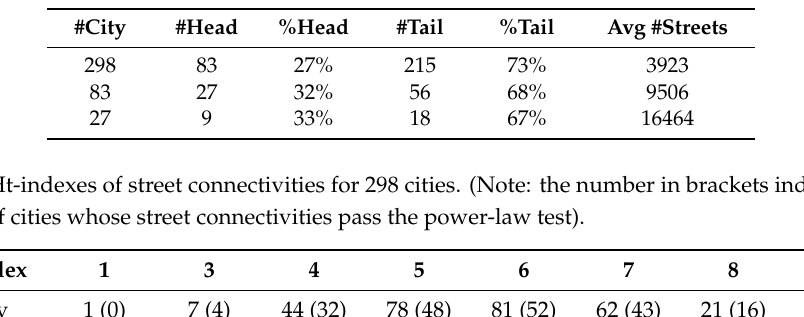
Table 3. Ht-indexes of street connectivities for 298 cities. (Note: the number in brackets indicates the number of cities whose street connectivities pass the power-law test).